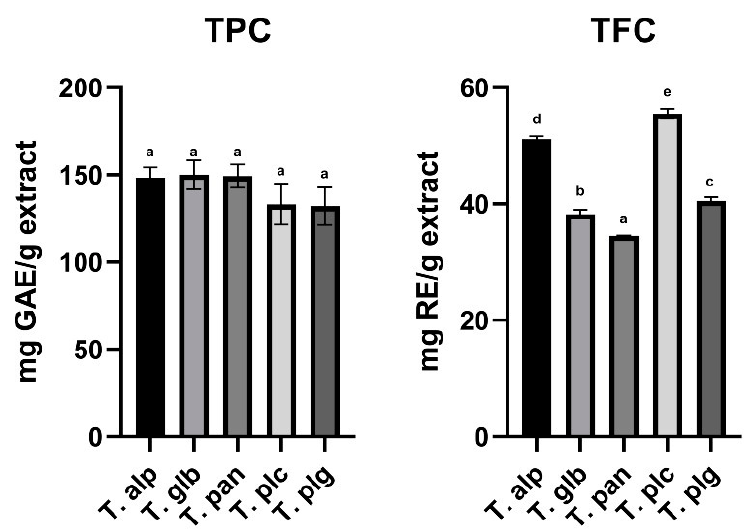
Figure 1. TPC and TFC values measured for the Thymus species studied. The results are expressed as average ± standard deviation of three parallel measurements. Statistical differences were assessed by one-way ANOVA, followed by Tukey’s HSD post hoc test ( α = 0.05). Different lower case letters indicate significant differences between extracts. T. alp — T. alpestris , T. glb — T. glabrescens , T. pan — T. pannonicus , T. plc — T. pulegioides , T. plg — T. pulcherimus .